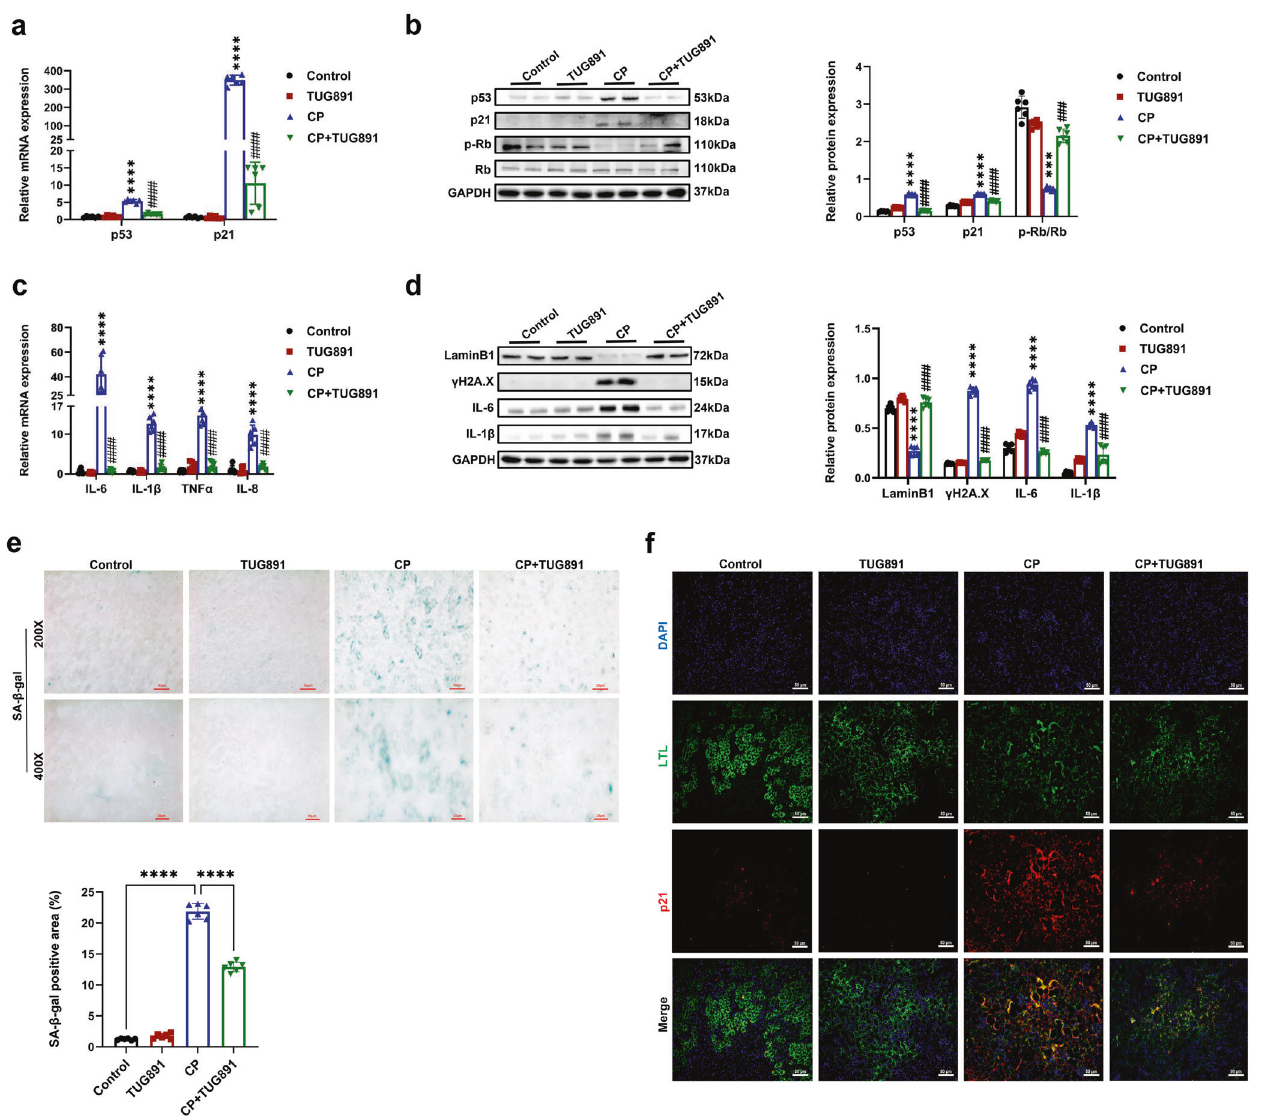
Fig. 3 Activation of FFAR4 by TUG891 ameliorated cellular senescence in cisplatin-induced AKI mice. a Relative mRNA expression of p53 and p21 in kidney tissues ( n = 6; **** P < 0.0001, CP vs . Control; #### P < 0.0001, CP + TUG891 vs. CP). b Protein expression of p53, p21, and p-Rb/Rb in kidneys was detected by western blotting and quanti fi ed by densitometry ( n = 6; **** P < 0.0001, *** P < 0.001, CP vs. Control; #### P < 0.0001, CP + TUG891 vs . CP). c Relative mRNA expression of IL-6, IL-1 β , TNF- α , and IL-8 in kidney tissues ( n = 6; **** P < 0.0001, CP vs. Control; #### P < 0.0001, CP + TUG891 vs. CP). d Protein expression of LaminB1, ɣ H2A.X, IL-6, and IL-1 β in kidneys was detected by western blotting and quanti fi ed by densitometry ( n = 6; **** P < 0.0001, CP vs. Control; #### P < 0.0001, CP + TUG891 vs . CP). e Representative images